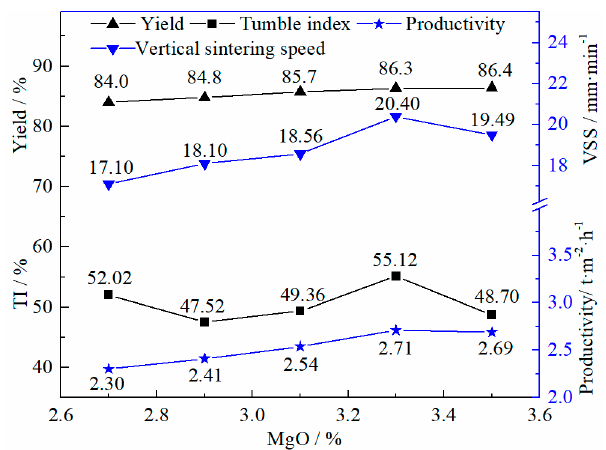
Figure 3. Sinter properties of HTCVM sinters with different MgO contents.